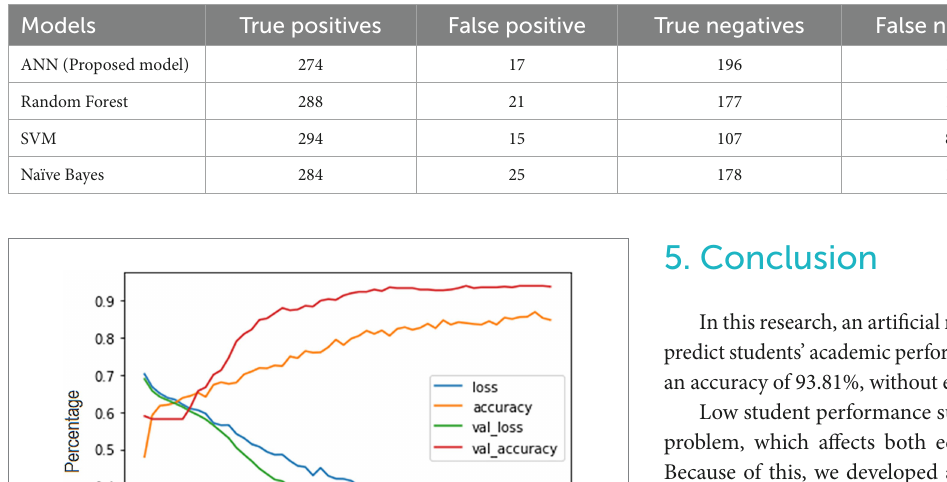
TABLE 3 Results of the confusion matrices.